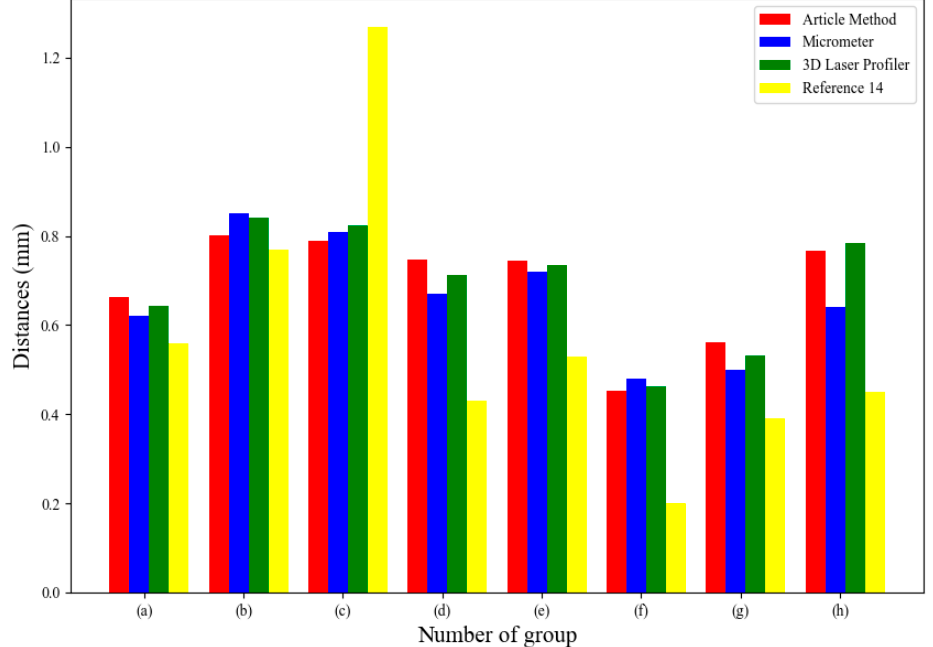
Figure 25. Comparison of the results of each group obtained by the four measurement methods.